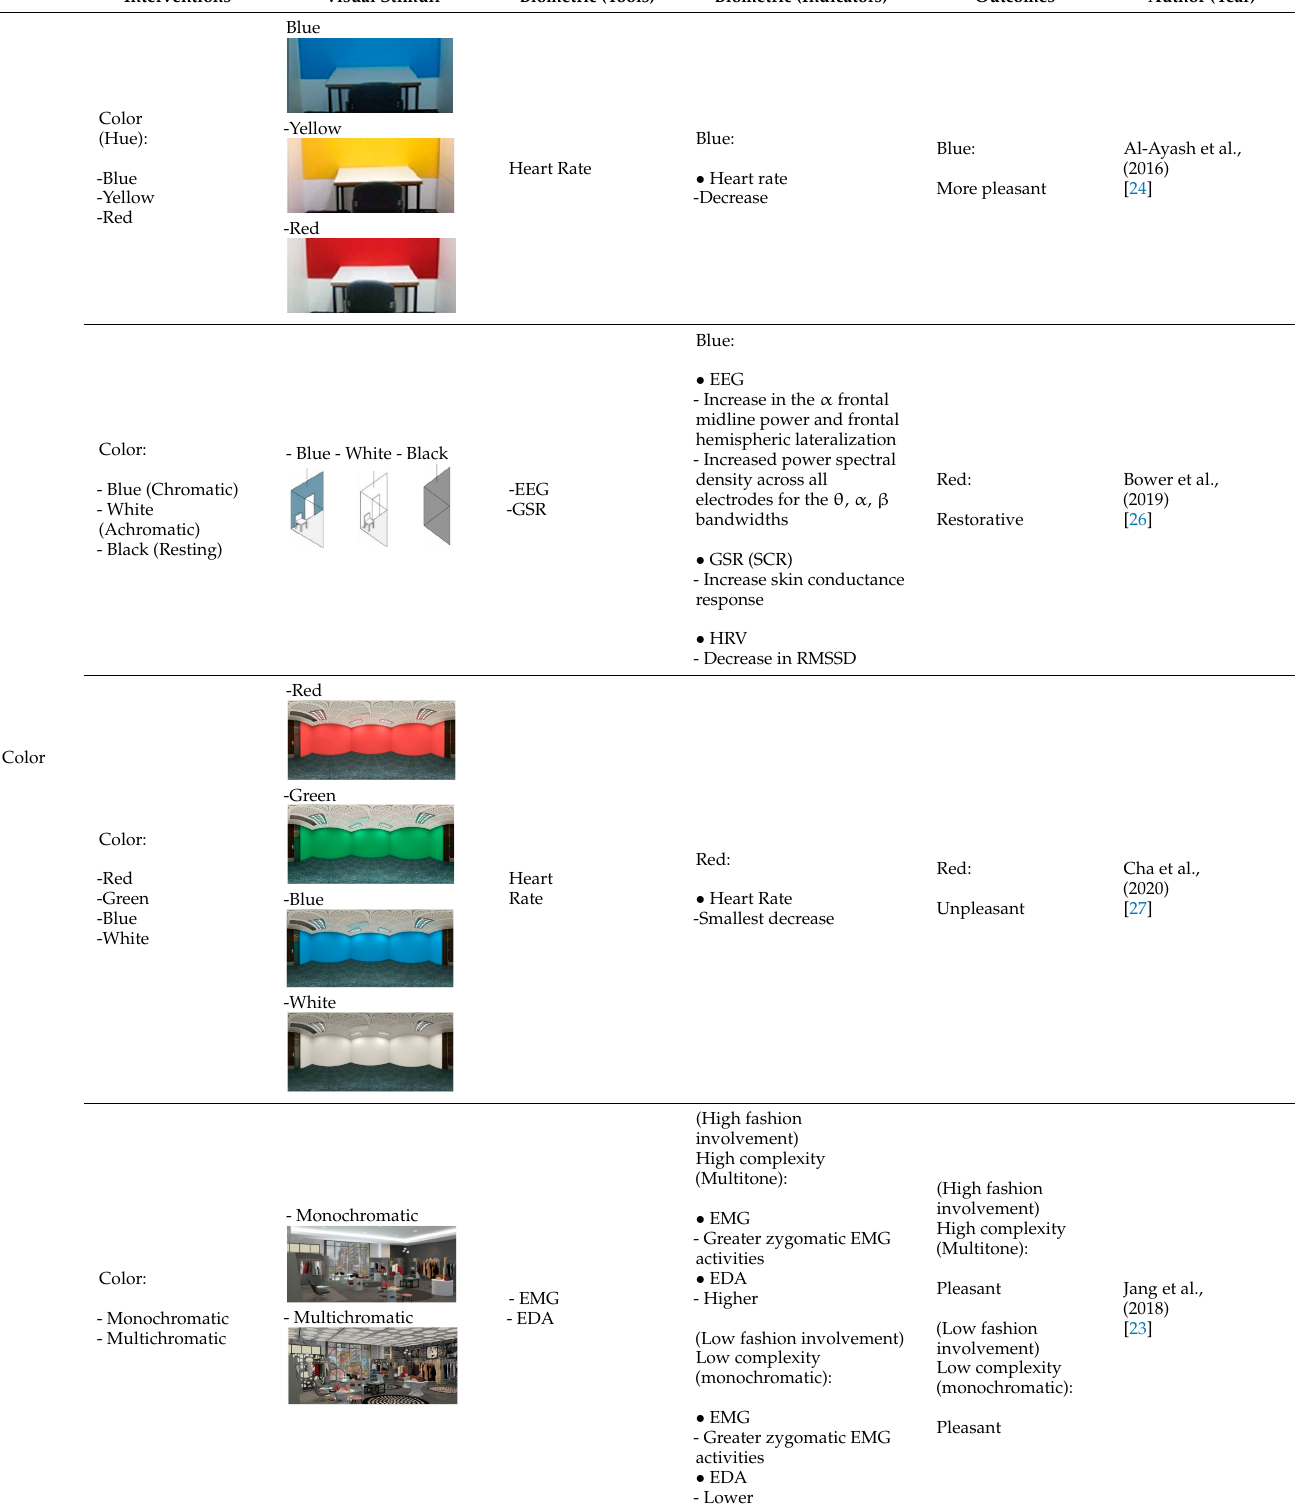
Al-Ayash et al., (2016) [24]